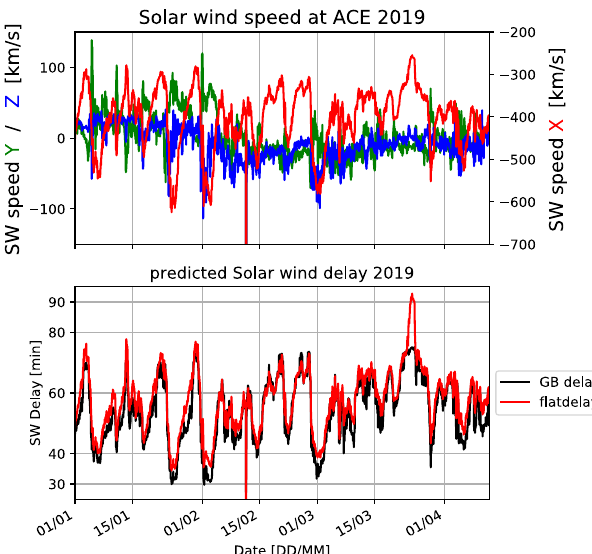
Fig. 6. Comparison of SW propagation delay prediction for the beginning of 2019 using the fl at delay method and a fully trained GB model. Continuous ACE level 2 hourly data is used for input.